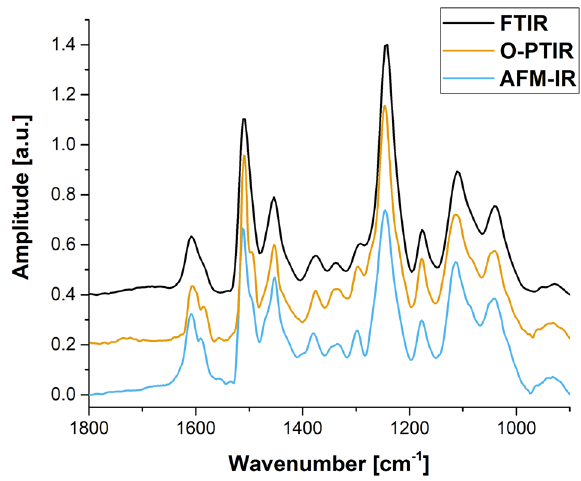
Fig. 1 Validation of spectral quality between FTIR, O-PTIR and AFM-IR spectroscopy. FTIR (black), O-PTIR (orange) and AFM-IR (sky blue) spectra collected for a microtomed section of a cured epoxy adhesive (~800 nm) placed on CaF 2 window. Raw spectra have been offset for better